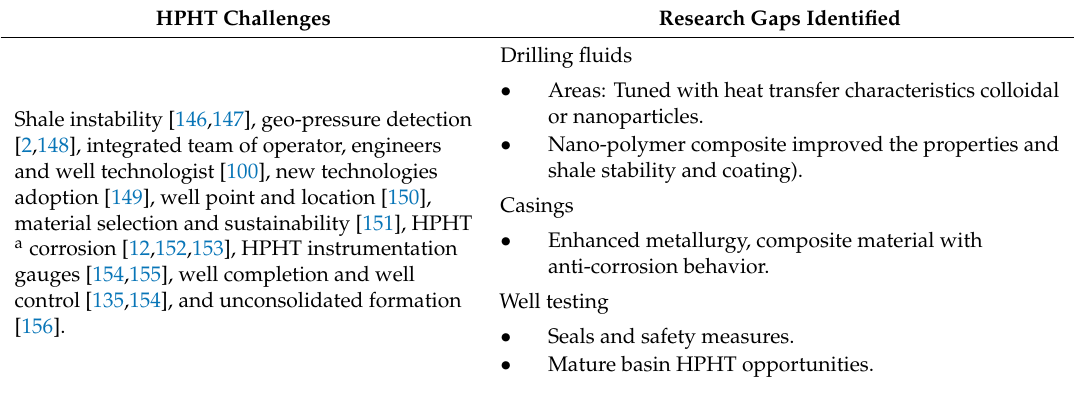
Table 8. An overview of HPHT unconventional reservoir challenges and research